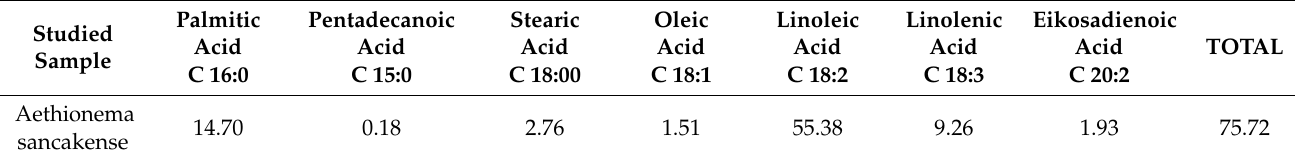
Table 2. Fatty acid composition (%) of Aethionema sancakense